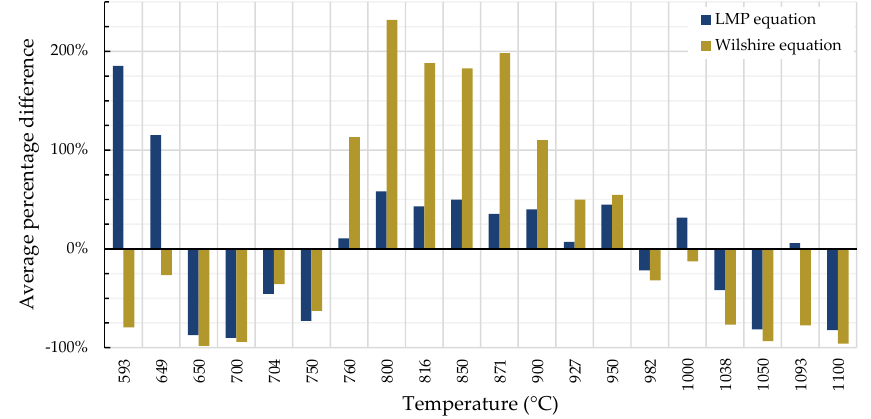
Figure 11. Average percentage difference of calculated and experimental rupture times for Inconel 617.